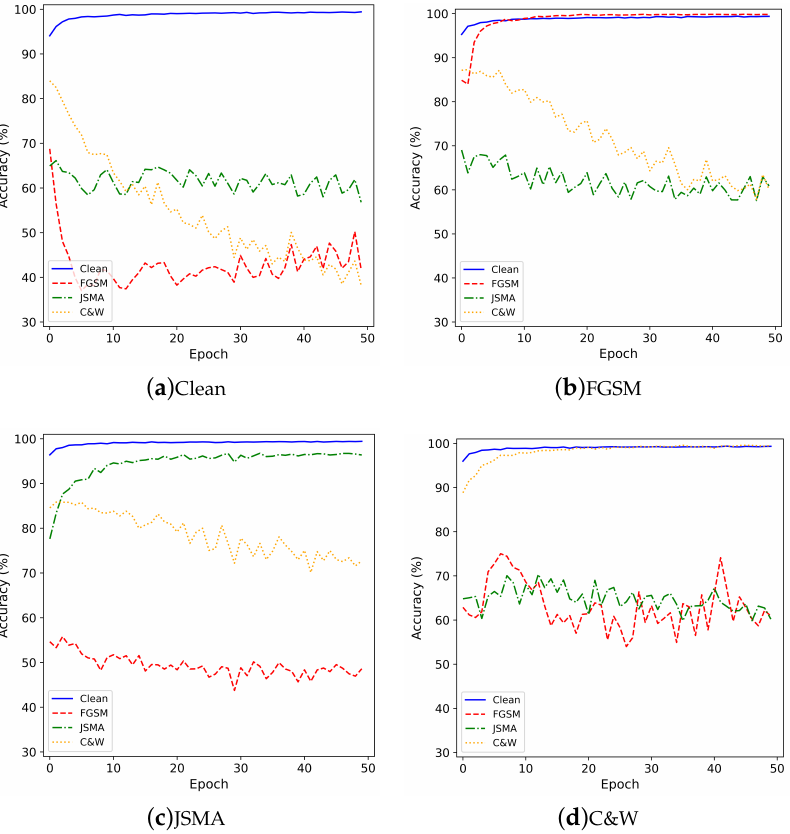
Figure 3. Accuracy of adversarially trained LeNet5 network on the test set with adversarial examples. Each models are trained with: ( a ) Clean; ( b ) FGSM; ( c ) JSMA; and ( d )